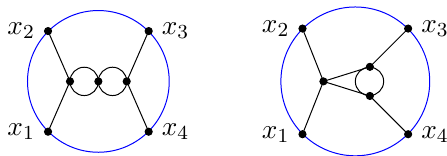
Figure 5 . One channel of the two-loop Necklace (left) and Ice cream (right) diagram. The other channels can be obtained by permutations of the boundary